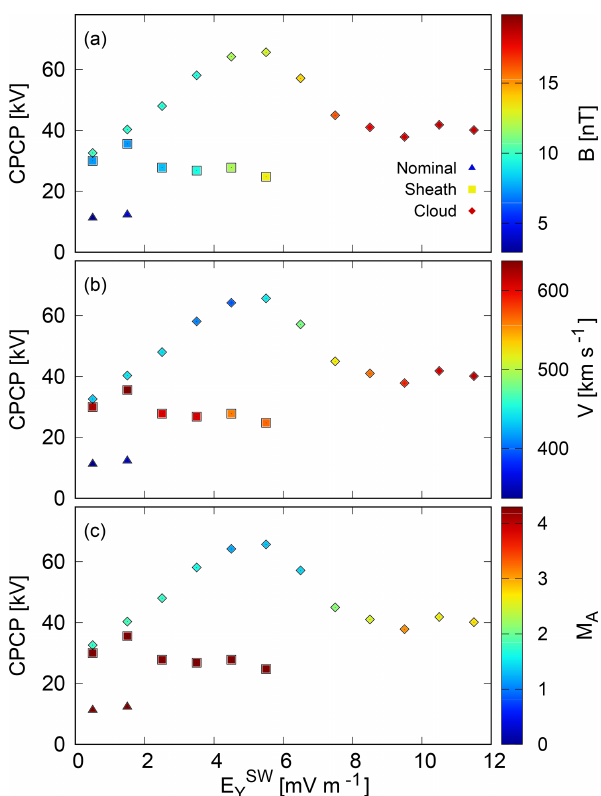
Figure 9. The CPCP as a function of the IMF E Y for the 2014 ICME cloud period, with nominal solar wind conditions before and after the ICME event taken into account separately. GUMICS-4 simulation data with 1min time resolution have been averaged by 10min and binned by upstream E Y with 0.5mVm − 1 intervals. Pan- els (a) , (b) and (c) show the magnitudes of the IMF, the upstream flow speed and the Alfvén–Mach number,